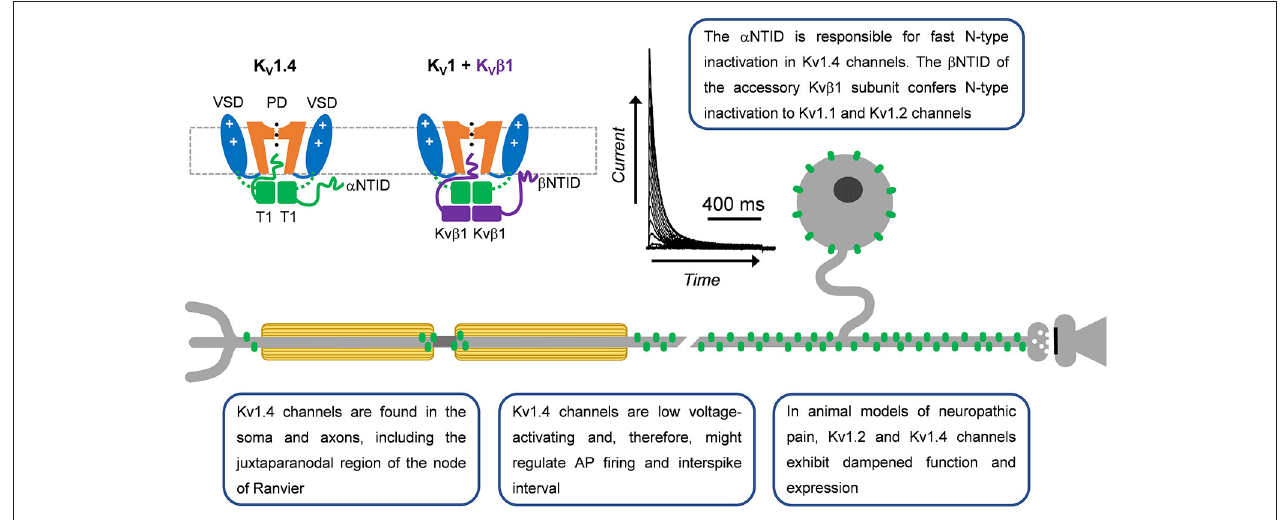
FIGURE 2 | A-type Kv1 channels in primary nociceptive neurons . Cartoon renderings of a Kv1 channel pore-forming a-subunit including characteristic voltage-sensing and pore domains (VSD and PD, respectively) and cytoplasmic tetramerization domain (T1). The alpha subunit N-terminal inactivation domain ( α NTID) from one subunit is shown occluding the open pore. The NTID of the Kv β 1 subunit ( β NTID) is similarly capable of occluding the open pore. As a result, the current profile exhibits a fast decay over time. A-type Kv1.4 channels are expressed in the somata and axons of unmyelinated and lightly myelinated fibers.